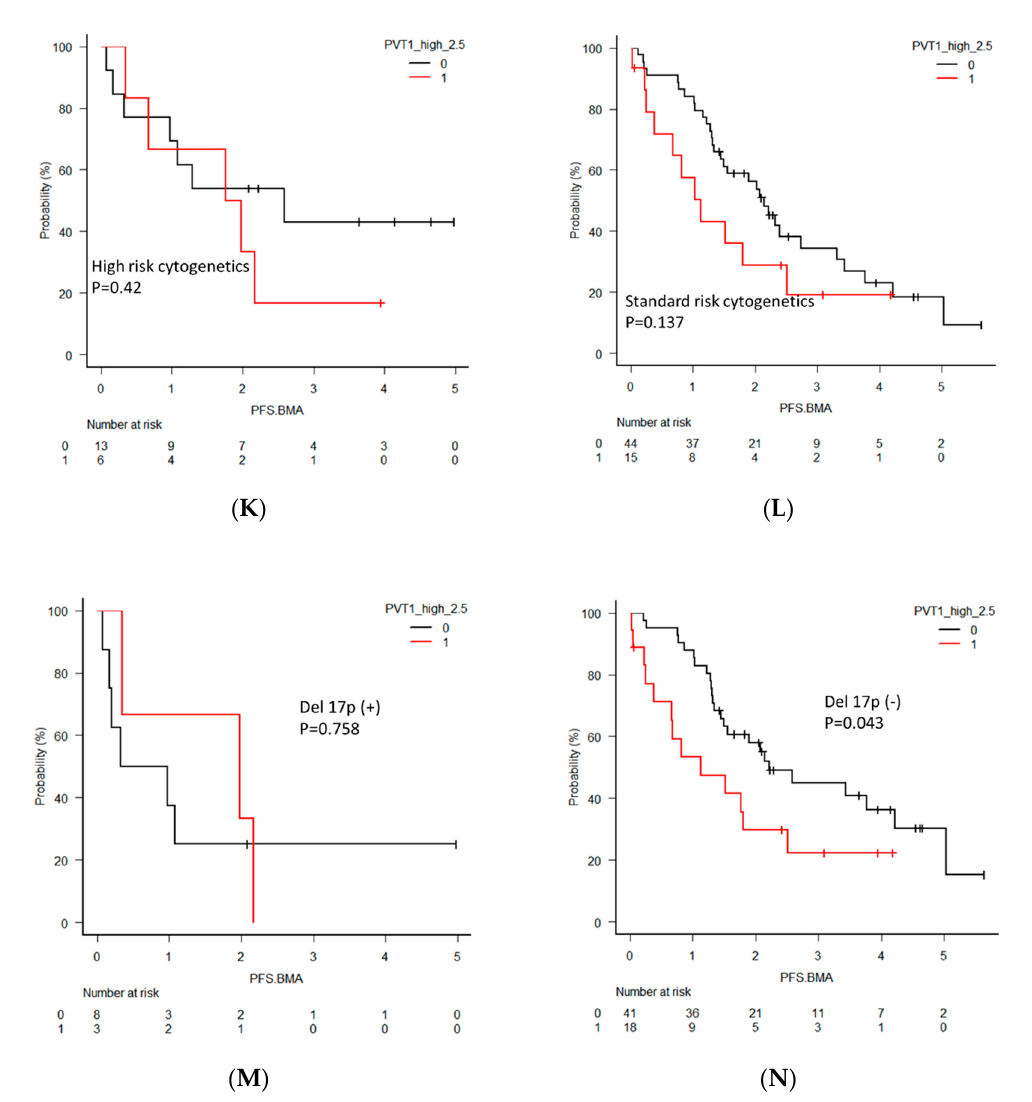
Figure 5. ( A ) Overall survival (OS) and ( B ) progression-free survival (PFS) in all newly diagnosed multiple myeloma (NDMM) patients divided into two groups by PVT1 expression level. ( C ) OS in NDMM patients eligible for autologous stem cell transplantation (ASCT). ( D ) OS in NDMM ineligible for ASCT. ( E ) PFS in NDMM eligible for ASCT. ( F ) PFS in NDMM ineligible for ASCT. ( G ) OS in NDMM with high-risk cytogenetics. ( H ) OS in NDMM with standard-risk cytogenetics. ( I ) OS in NDMM with deletion 17p (del 17p). ( J ) OS in NDMM without del 17p. ( K ) PFS in NDMM with high-risk cytogenetics. ( L ) PFS in NDMM with standard-risk cytogenetics. ( M ) PFS in NDMM with del 17p. ( N ) PFS in NDMM without del